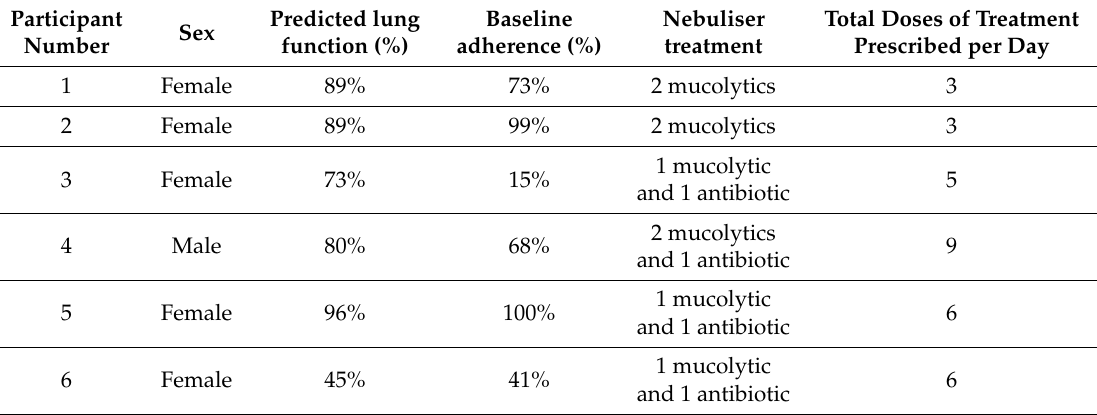
Table 2. Demographics and nebuliser treatments of participants.